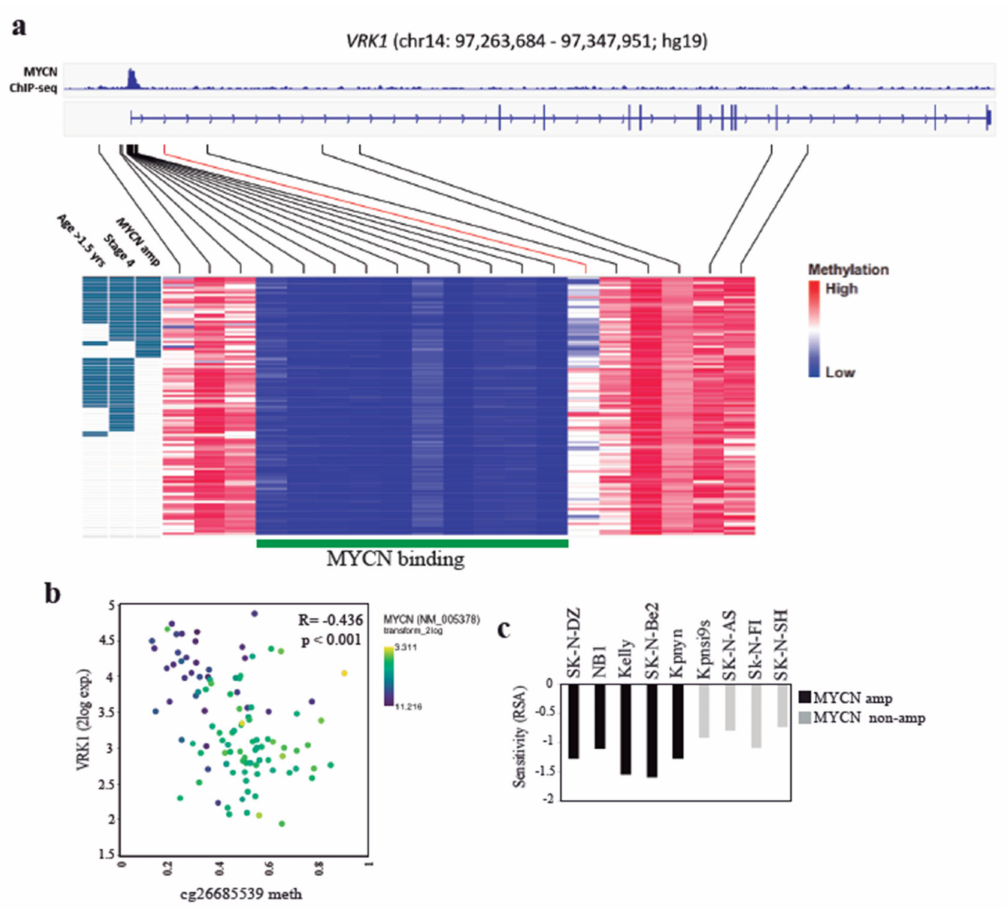
Figure6. VRK1promoterishypomethylatedinMYCN-amplifiedNBtumors. ( a